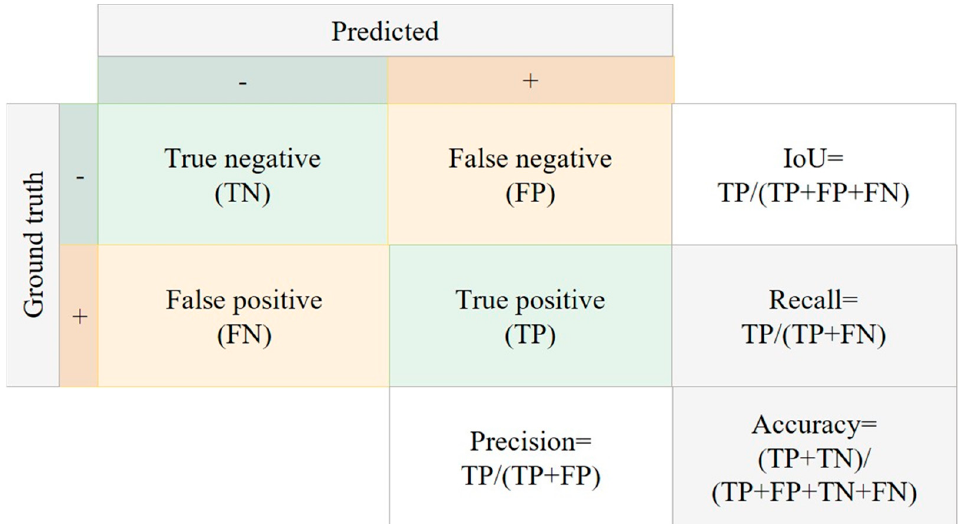
Figure 4. Confusion matrix applied to the evaluation